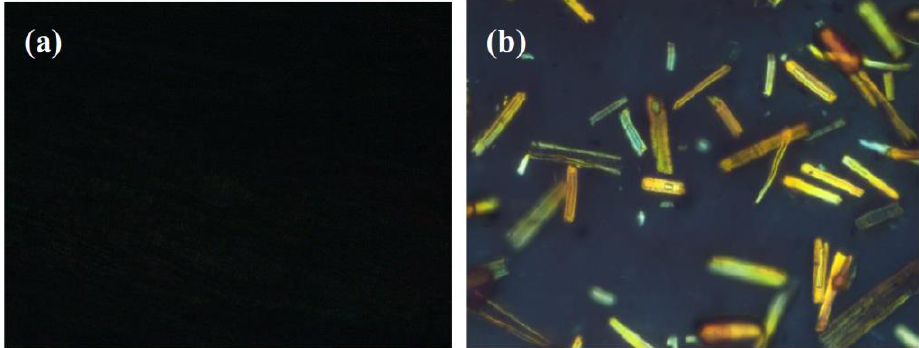
Figure 5. Polarizing microscope (POM) of SCFs-HLP at room temperature ( a ) and at melting point ( b ).